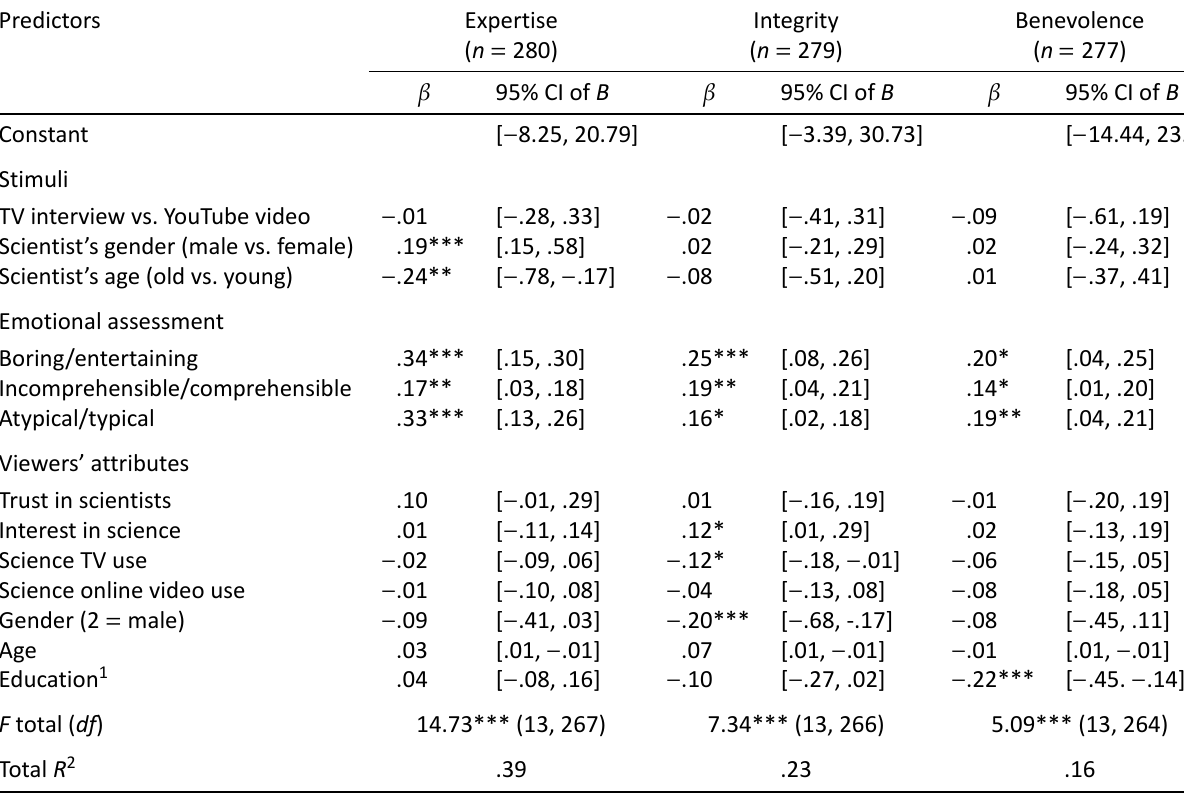
Table 5. Linear regression predicting scientific experts’ perceived